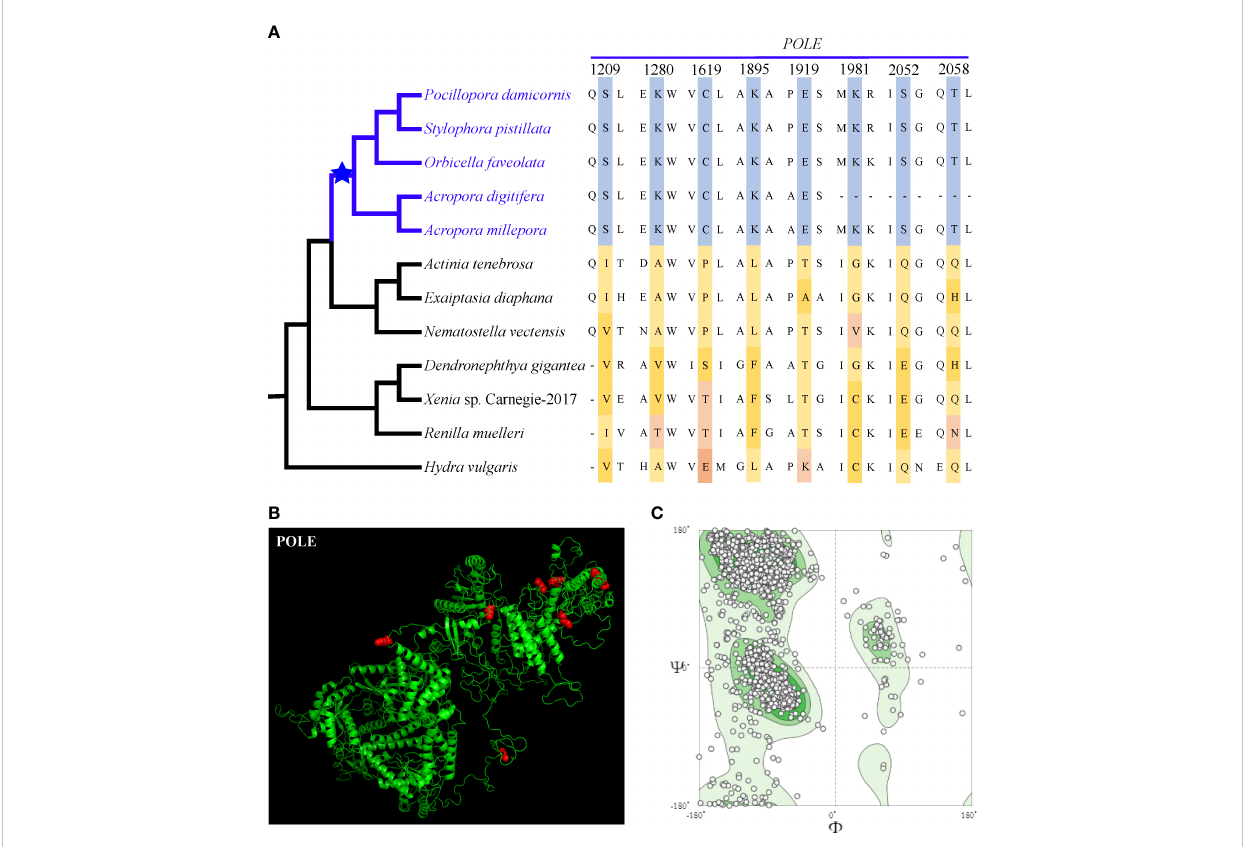
FIGURE 4 (A) Positive selection sites of POLE shared by extant stony corals, which are marked in red in (B) 3D structural modeling. (C) The quality evaluation of the 3D structural modeling. Most of the points are in the dark green area, indicating that our predictions are of high